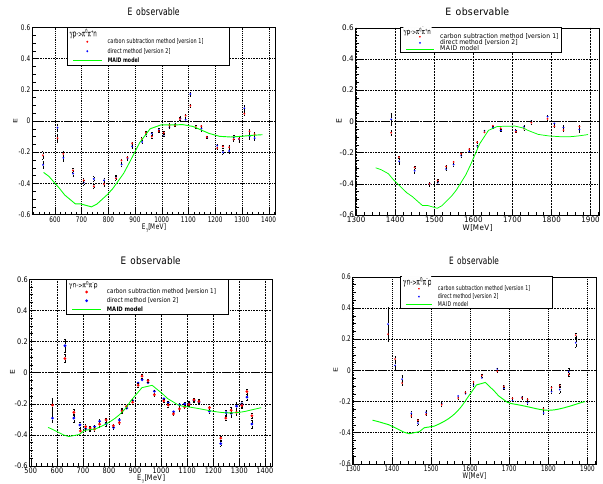
Figure 6: E-observable plots in terms of E γ (photon en- ergy) and W (center of mass energy) for γ p → π 0 π + n (up- per row) and for γ n → π 0 π − p (bottom row); Red dots are for the method with carbon subtraction and the Blue dots correspond to the direct method; and the green lineshape corresponds to that of MAID model prediction